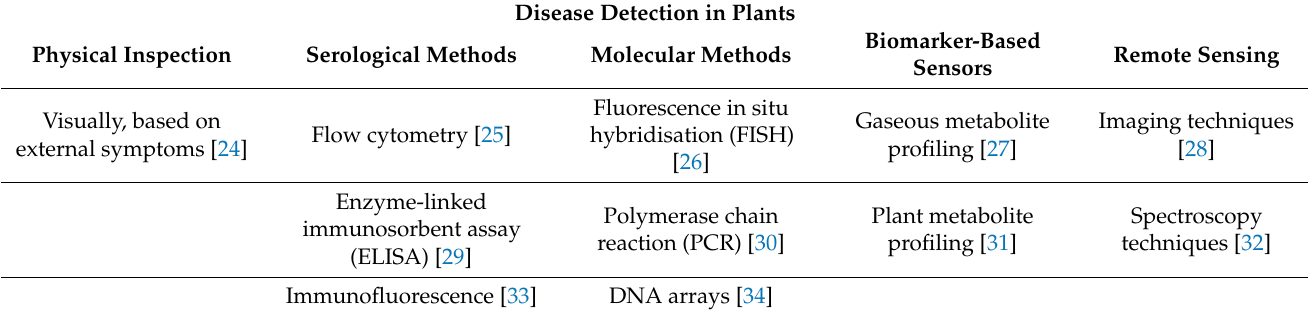
Table 1. Methods for plant disease